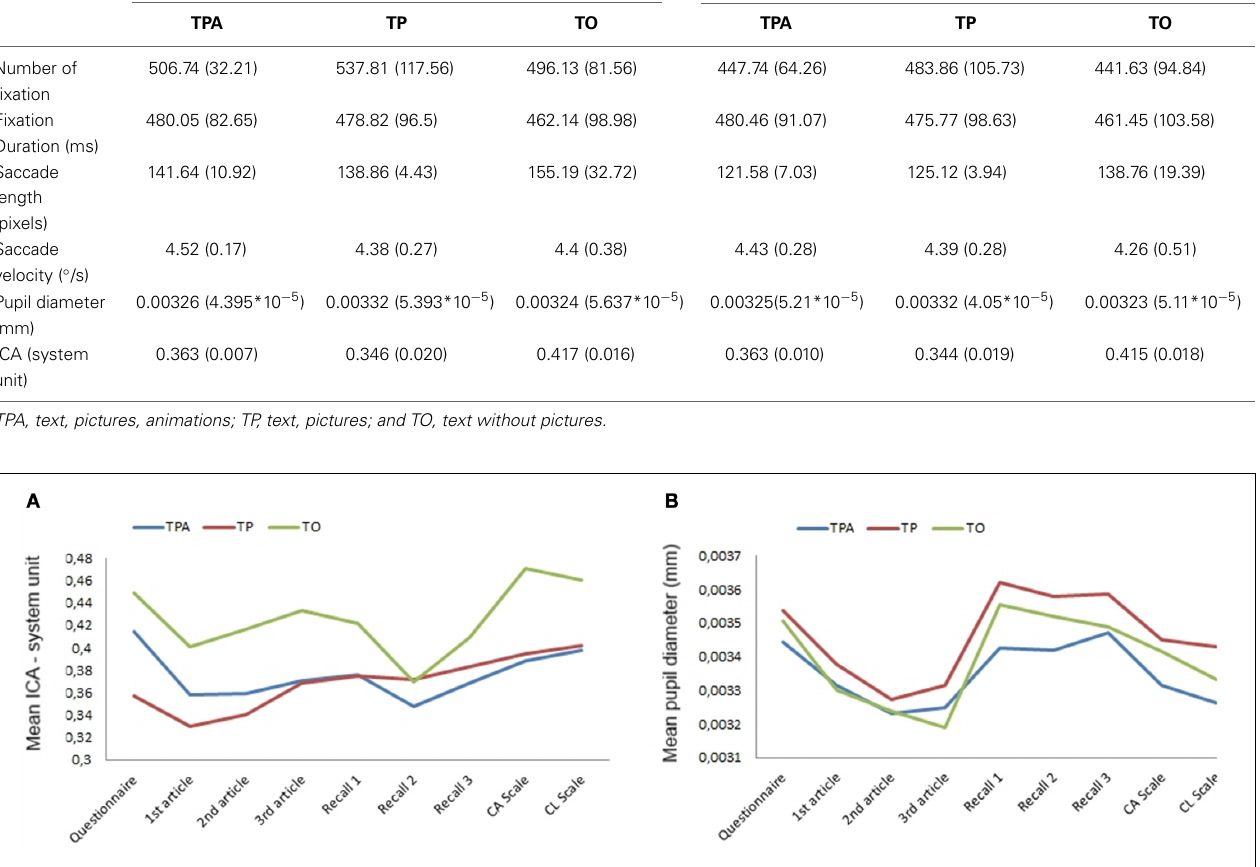
FIGURE 1 | Phase 2—Mean ICA (A) and mean pupil diameter (B) for each step of the experimental run in text, pictures and animations (TPA); text and pictures (TP), and text-only (TO) version.